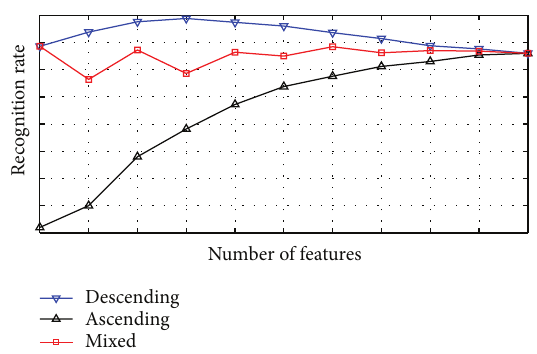
Figure 1: Illustration of recognition rate curves in descending, ascending, and mixed orders, as observed in